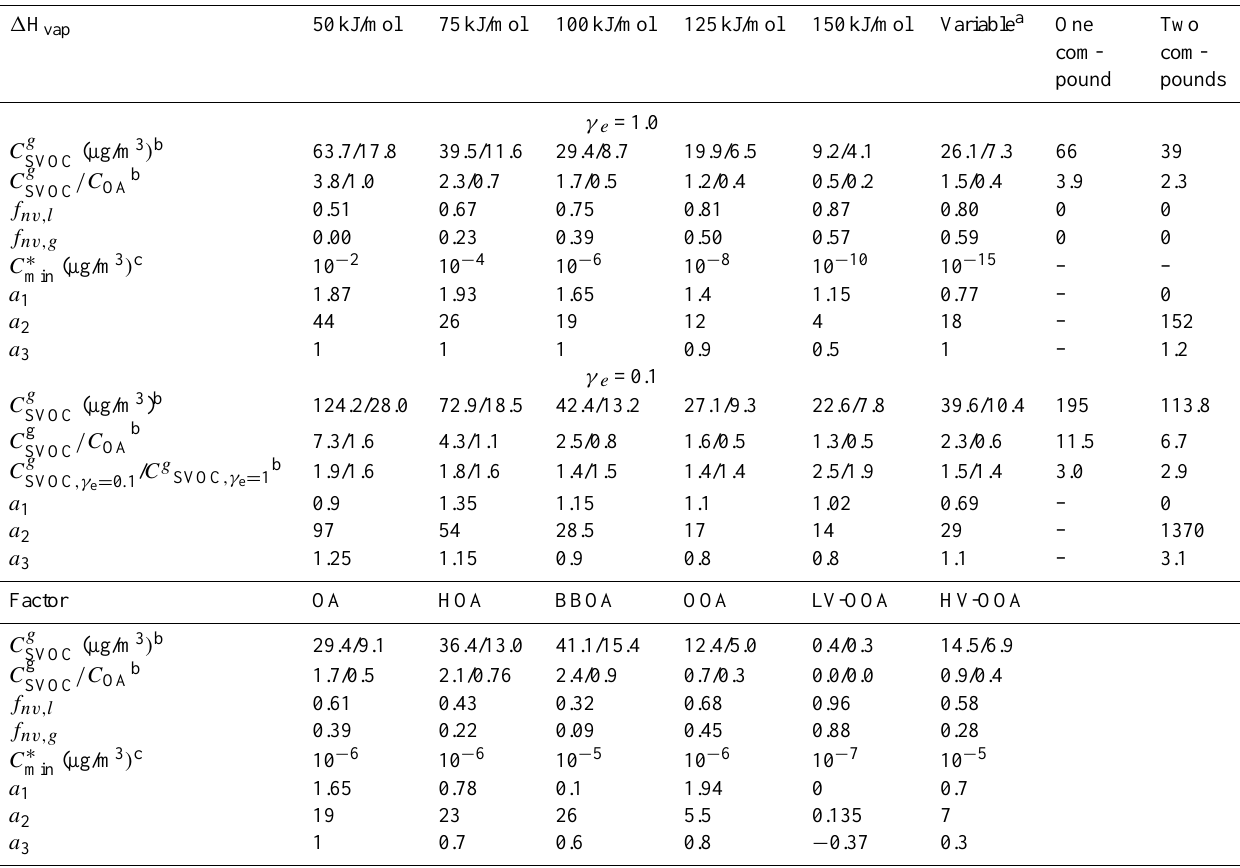
Table 1. Parameters describing the volatility basis sets determined for the various 1H vap cases. Values are shown for the γ e =1 and γ e =0.1 cases, along with the values determined for the individual organic aerosol